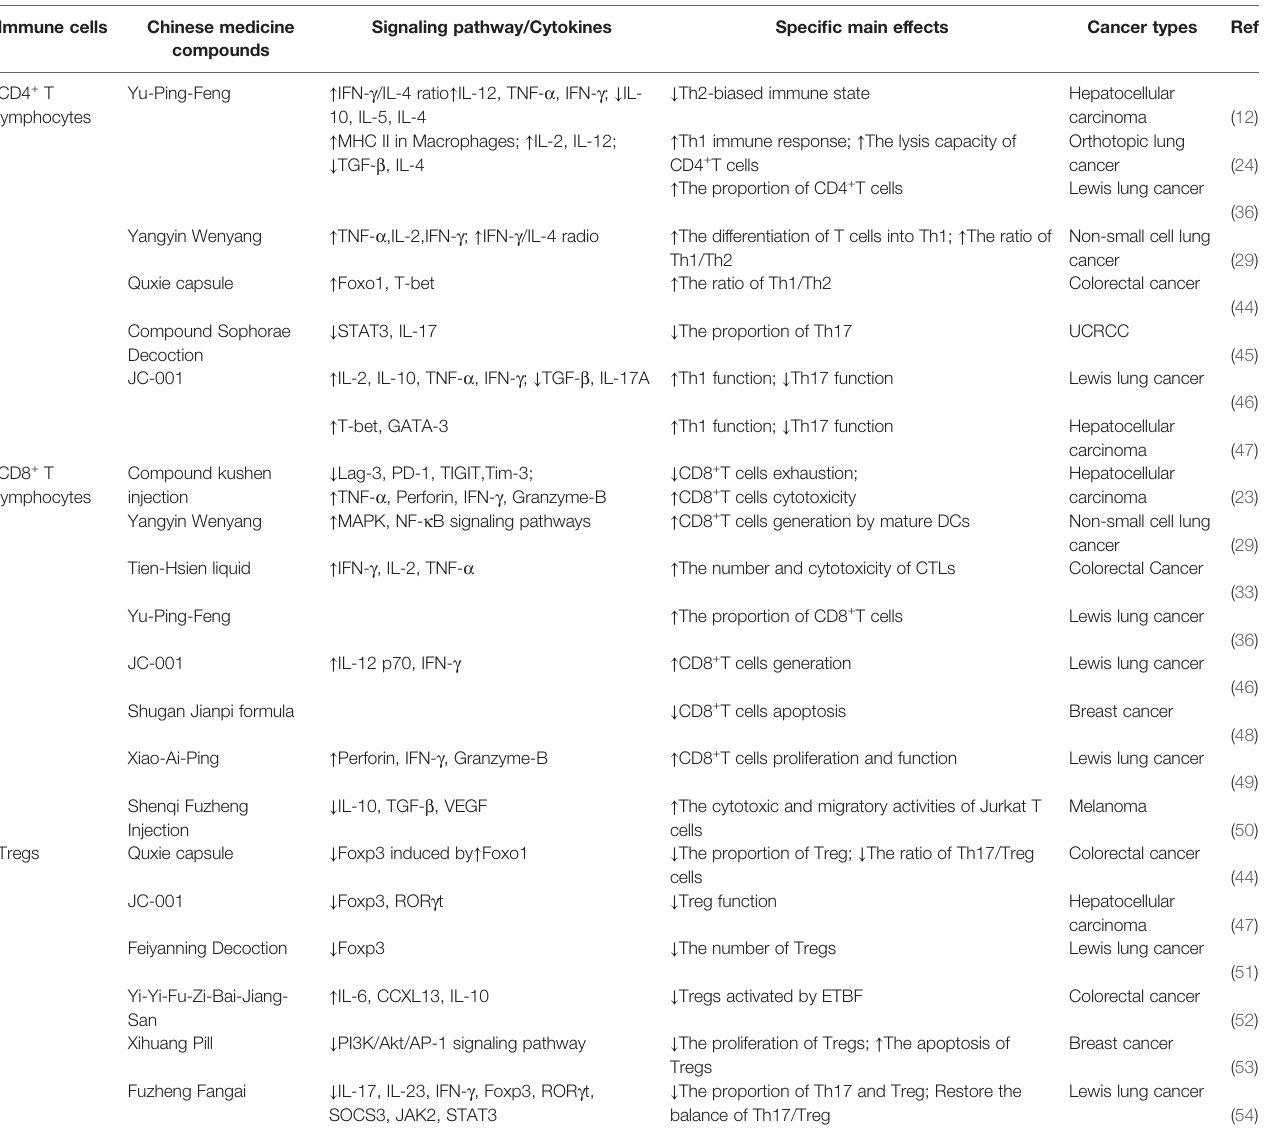
TABLE 2 | Adaptive immune cells impacted by Chinese medicine